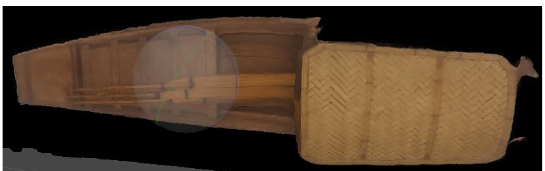
Figure 6b. Small Junk Model creating using Cell phone Images Agisoft MetaShape